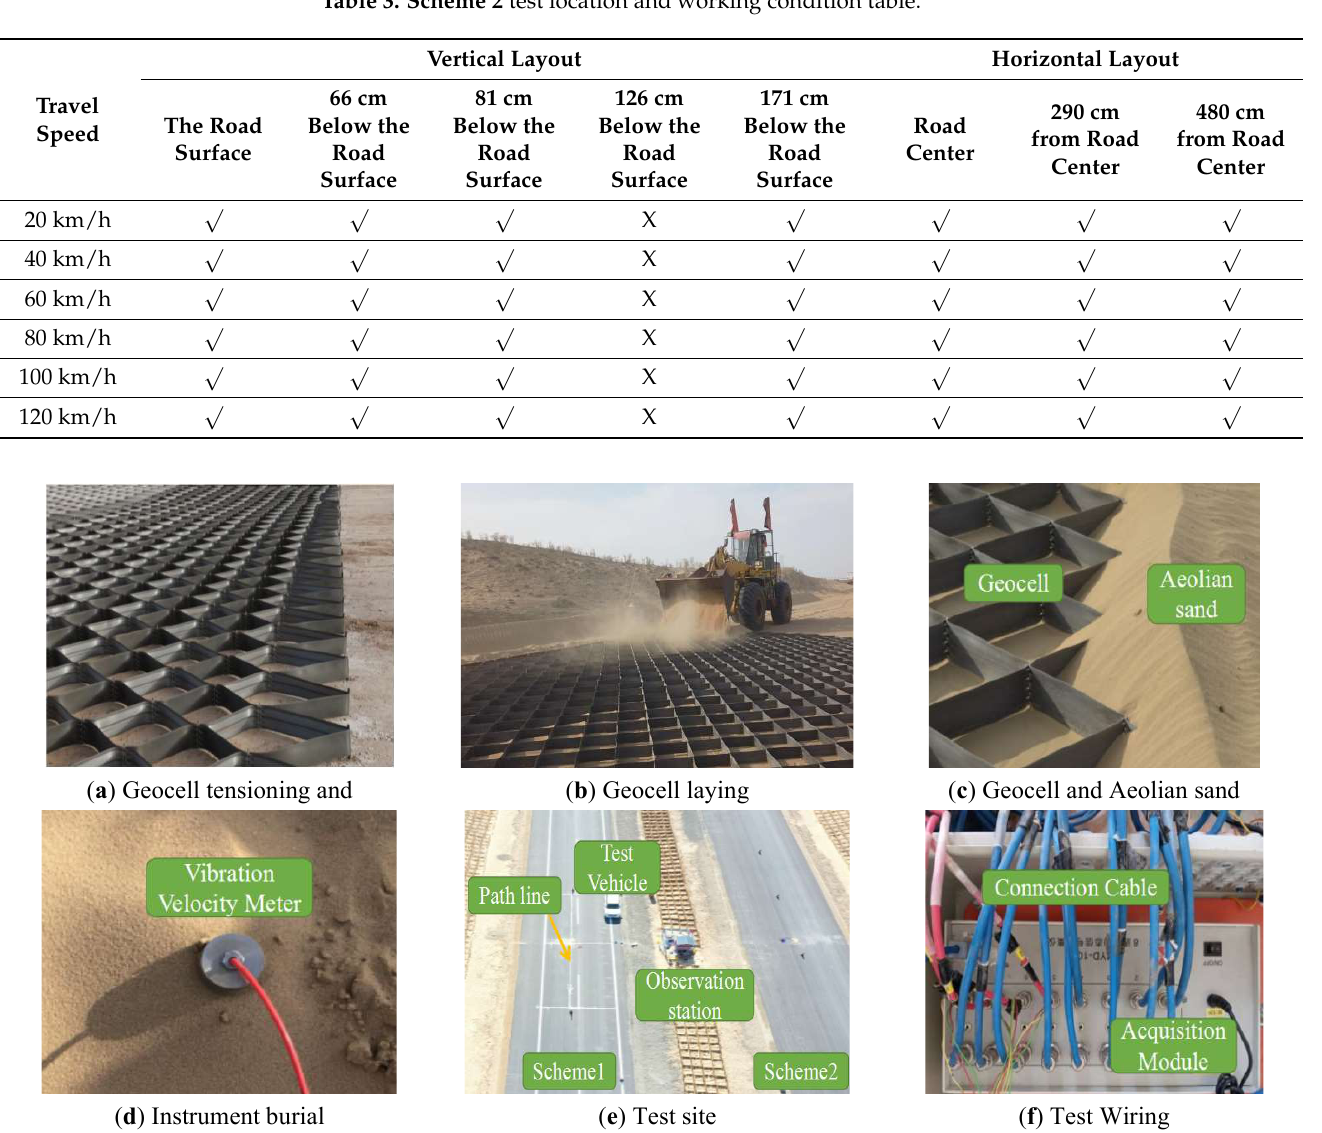
Table 3. Scheme 2 test location and working condition table.